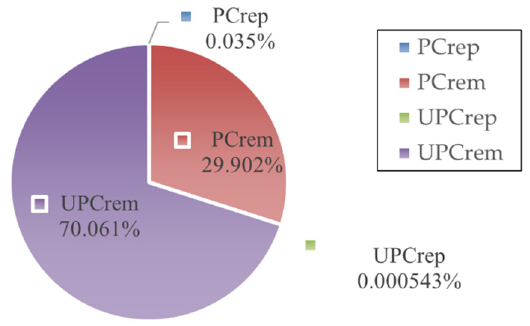
Figure 5. Different maintenance costs of the landing gear system.